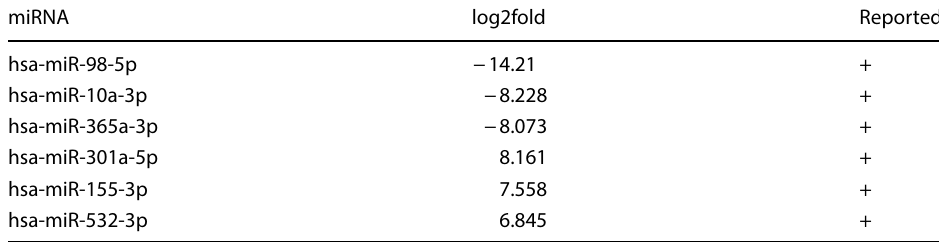
specified transcripts are not indicated in any cancer-related